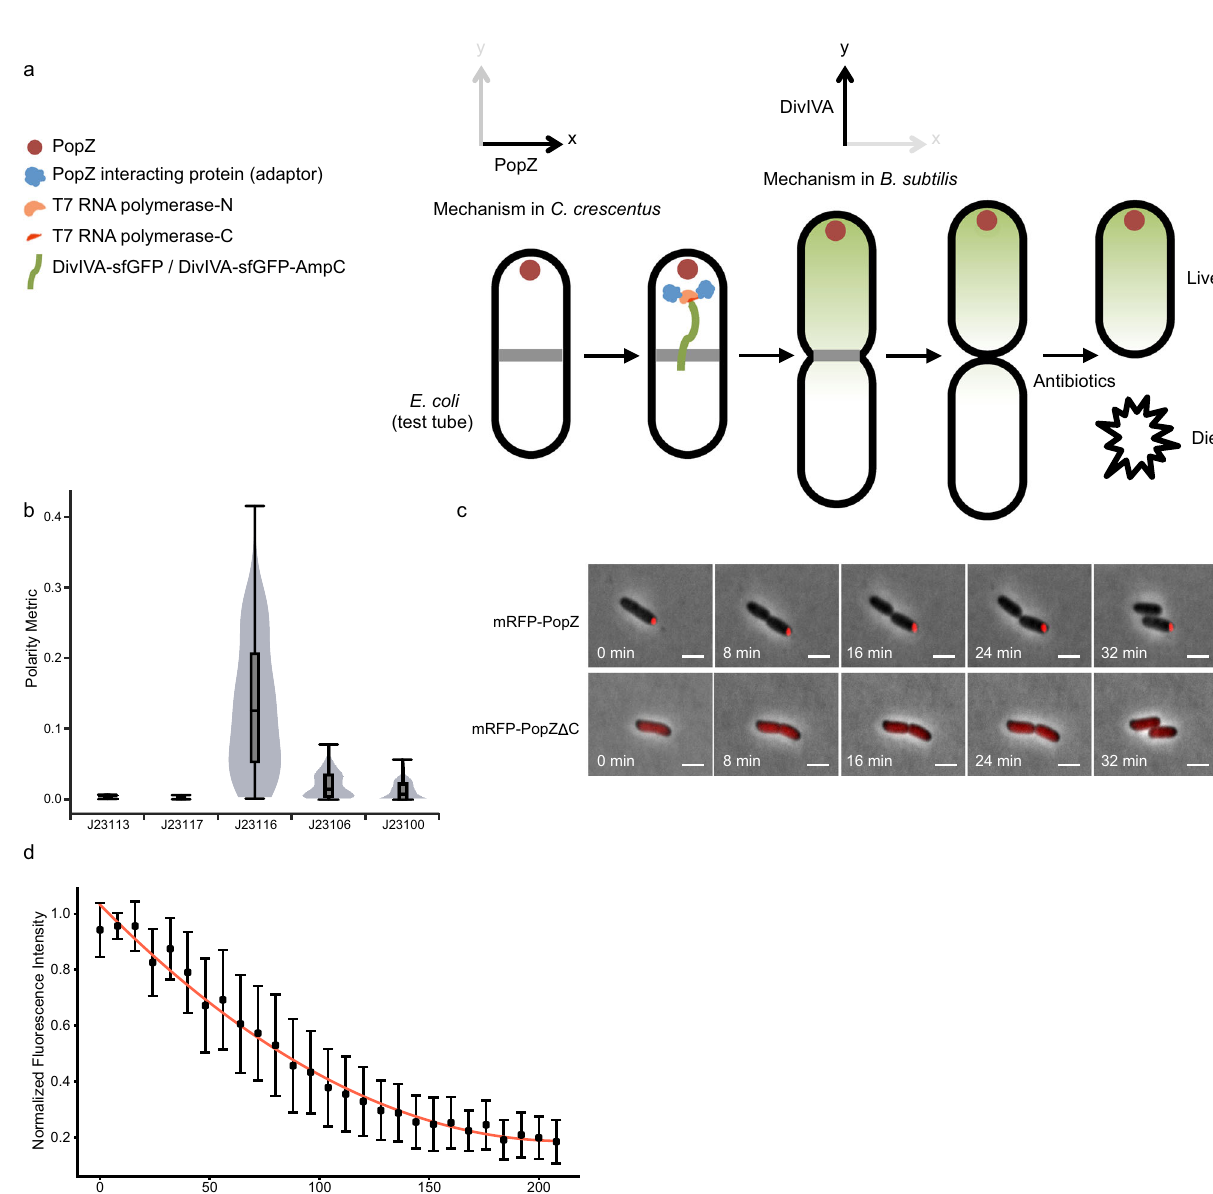
Fig. 1 Robust polarity basis for constructing intracellular gradient and asymmetric division in E. coli . a Graphical illustration of the regulatory layers for asymmetric gene expression and differentiation in E. coli . Two orthogonal mechanisms ( x axis: PopZ from C. crescentus ; y axis: DivIVA from B. subtilis ) were introduced in E. coli to probe the essential features. Split RNA polymerases (N and C halves, shown in light and dark orange) were recruited to PopZ (shown in red) via PopZ-interacting proteins that served as adaptors (shown in blue). The gene expression product, DivIVA-sfGFP or DivIVA-sfGFP-AmpC (shown in green), was restrained from diffusion toward the mid cell and asymmetrically segregated at the fi rst cell division. When two daughter cells were challenged with ampicillin, one cell survived and the other died. b Quanti fi cation of polarity metric for Anderson promoter series ( “ Methods ” ); n = 64, 160, 164, 134, and 155 cells for J23113, J23117, J23116, J23106, and J23100, respectively. Center line, median; box limits, upper and lower quartiles; whiskers, 1.5× interquartile range. c Time-lapse imaging of cells expressing mRFP-PopZ (top) and mRFP-PopZ Δ C (bottom) from the Anderson promoter J23116. Scale bars: 1 μ m. d Quanti fi cation of mRFP-PopZ stability. mRFP-PopZ expression was induced from P BAD with 2% arabinose for 24 h at 37 °C before time-lapse imaging. Fluorescence intensity was normalized by the maximal intensity. Dots, mean; Error bars, s.d. ( n = 60 cells). Source data are provided as a Source Data fi